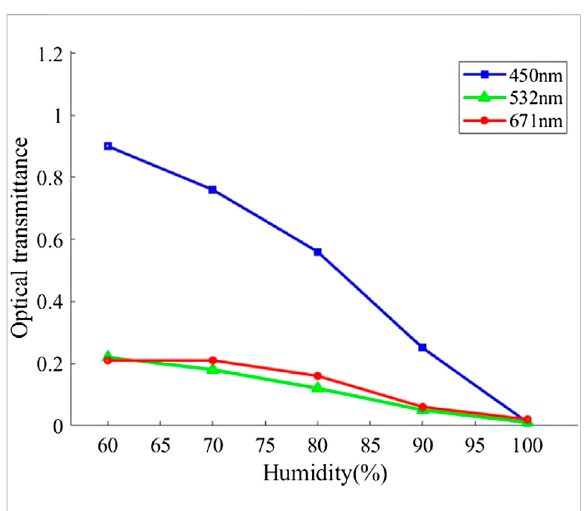
FIGURE 12 Relationship between light intensity transmittance and humidity at various wavelengths.